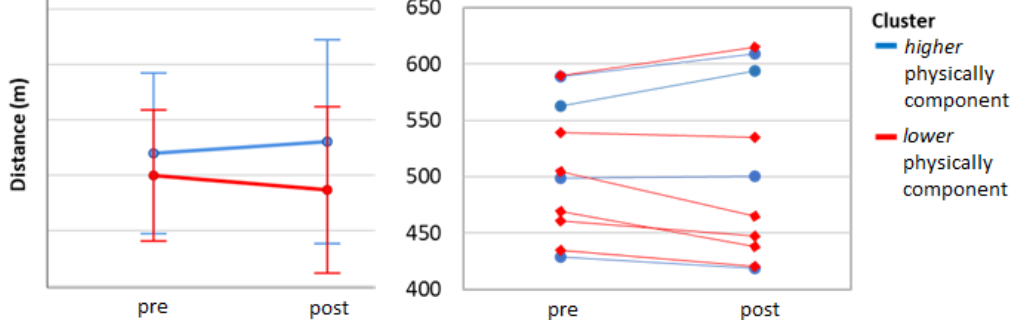
Figure 7. The 6-MWT mean split clusters. Two clusters were formed by using a simple mean split of the baseline distance covered during the 6MWT. Cluster 1, in blue, represents the faster sub-group, and cluster 2, in red, the slower group.